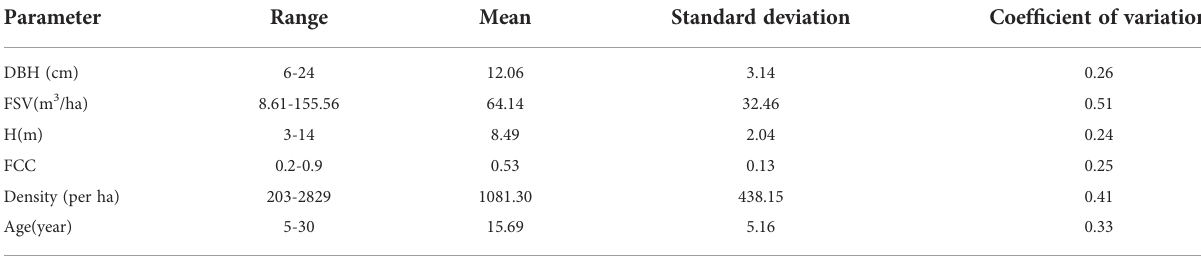
TABLE 1 The statistics results of selected samples.